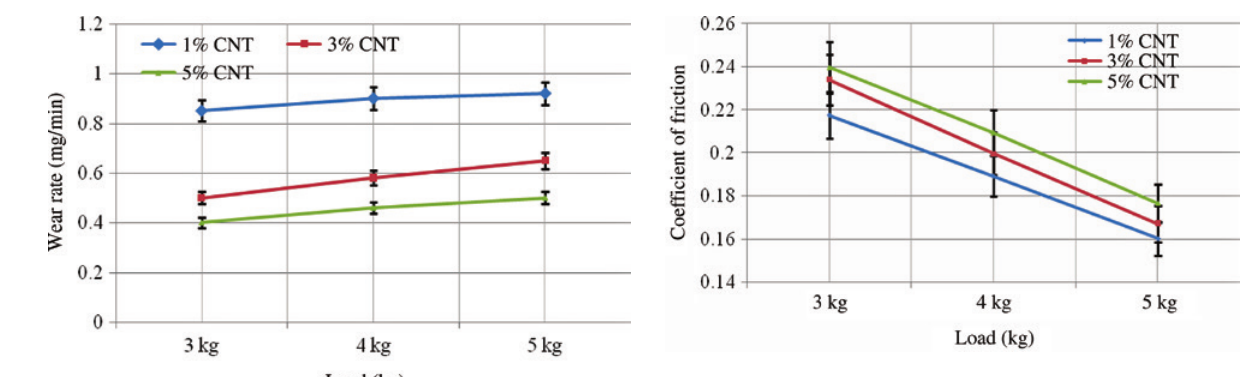
Figure 8: Difference in COF with respect to load for different % of